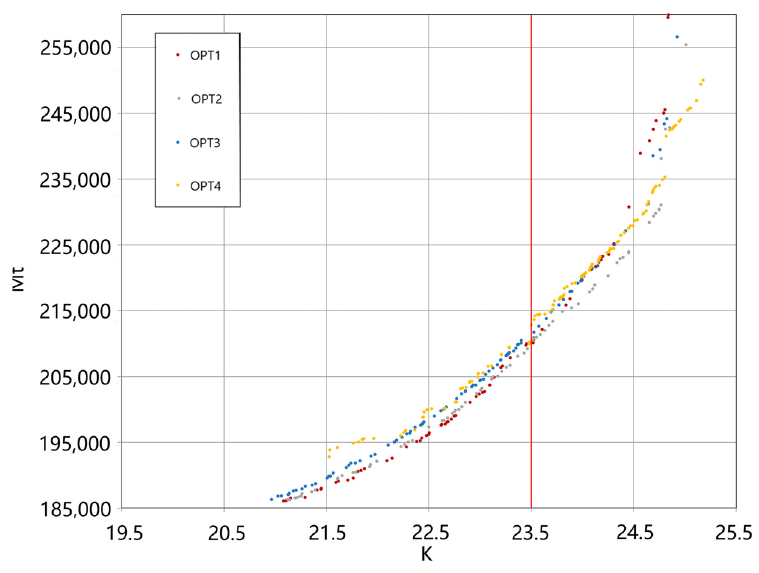
Figure 9. The pareto frontiers of the four optimization results.